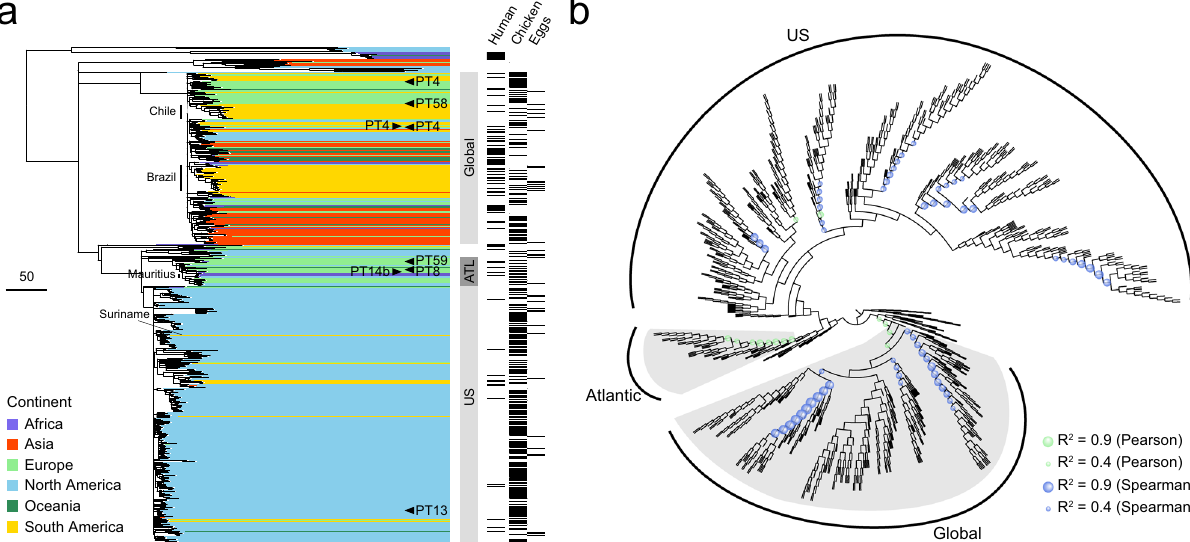
Fig. 4 Global phylogeny Salmonella Enteritidis from poultry. a Maximum-likelihood phylogeny of 914 selected poultry, human, and other isolates from 46 countries. The tree is rooted at midpoint. Three major lineages (Global, Atlantic, and US) are delineated. Each isolate is color coded by the continent of origin. The isolates from humans and poultry (including chickens and eggs) are indicated. Poultry Salmonella Enteritidis clades speci fi c to Chile, Brazil, and Mauritius are delineated. Arrowheads indicate isolates whose phage types are publicly available. ATL, Atlantic. The scale bar indicates 50 SNPs. b Circular cladogram of the same maximum-likelihood phylogeny of the 914 isolates. Colored circles indicate internal nodes that have a squared coef fi cient ( R 2 ) of the Spearman or Pearson correlation between isolation years and branch lengths >0.4. The sizes of the circle are proportional to the values of R 2 (0.4 – 0.9). The Global and the Atlantic lineages that exhibit strong temporal signals of SNP accumulation are shaded in